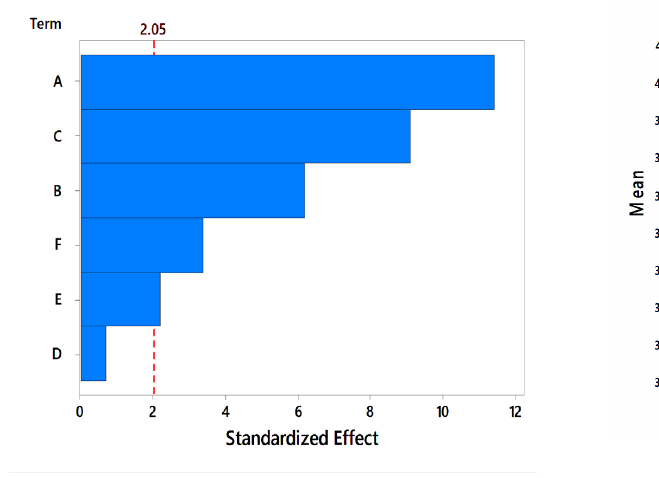
Table 7. The PB design matrix for nitrogen sources with the response.